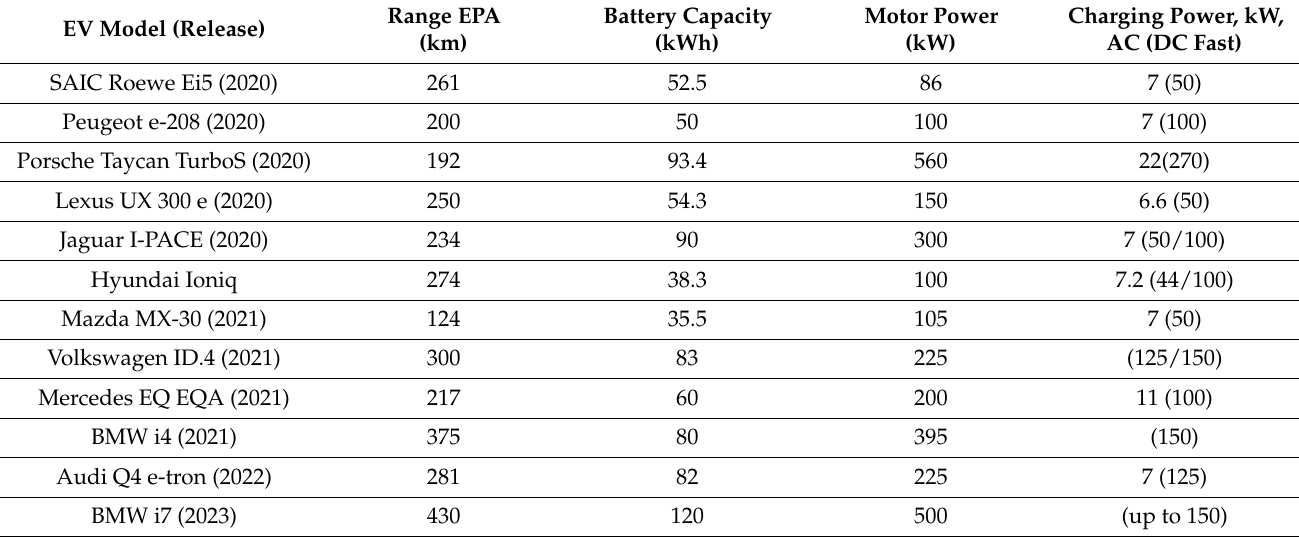
Table 2. Some of the EVs’ characteristics including battery capacity [11].